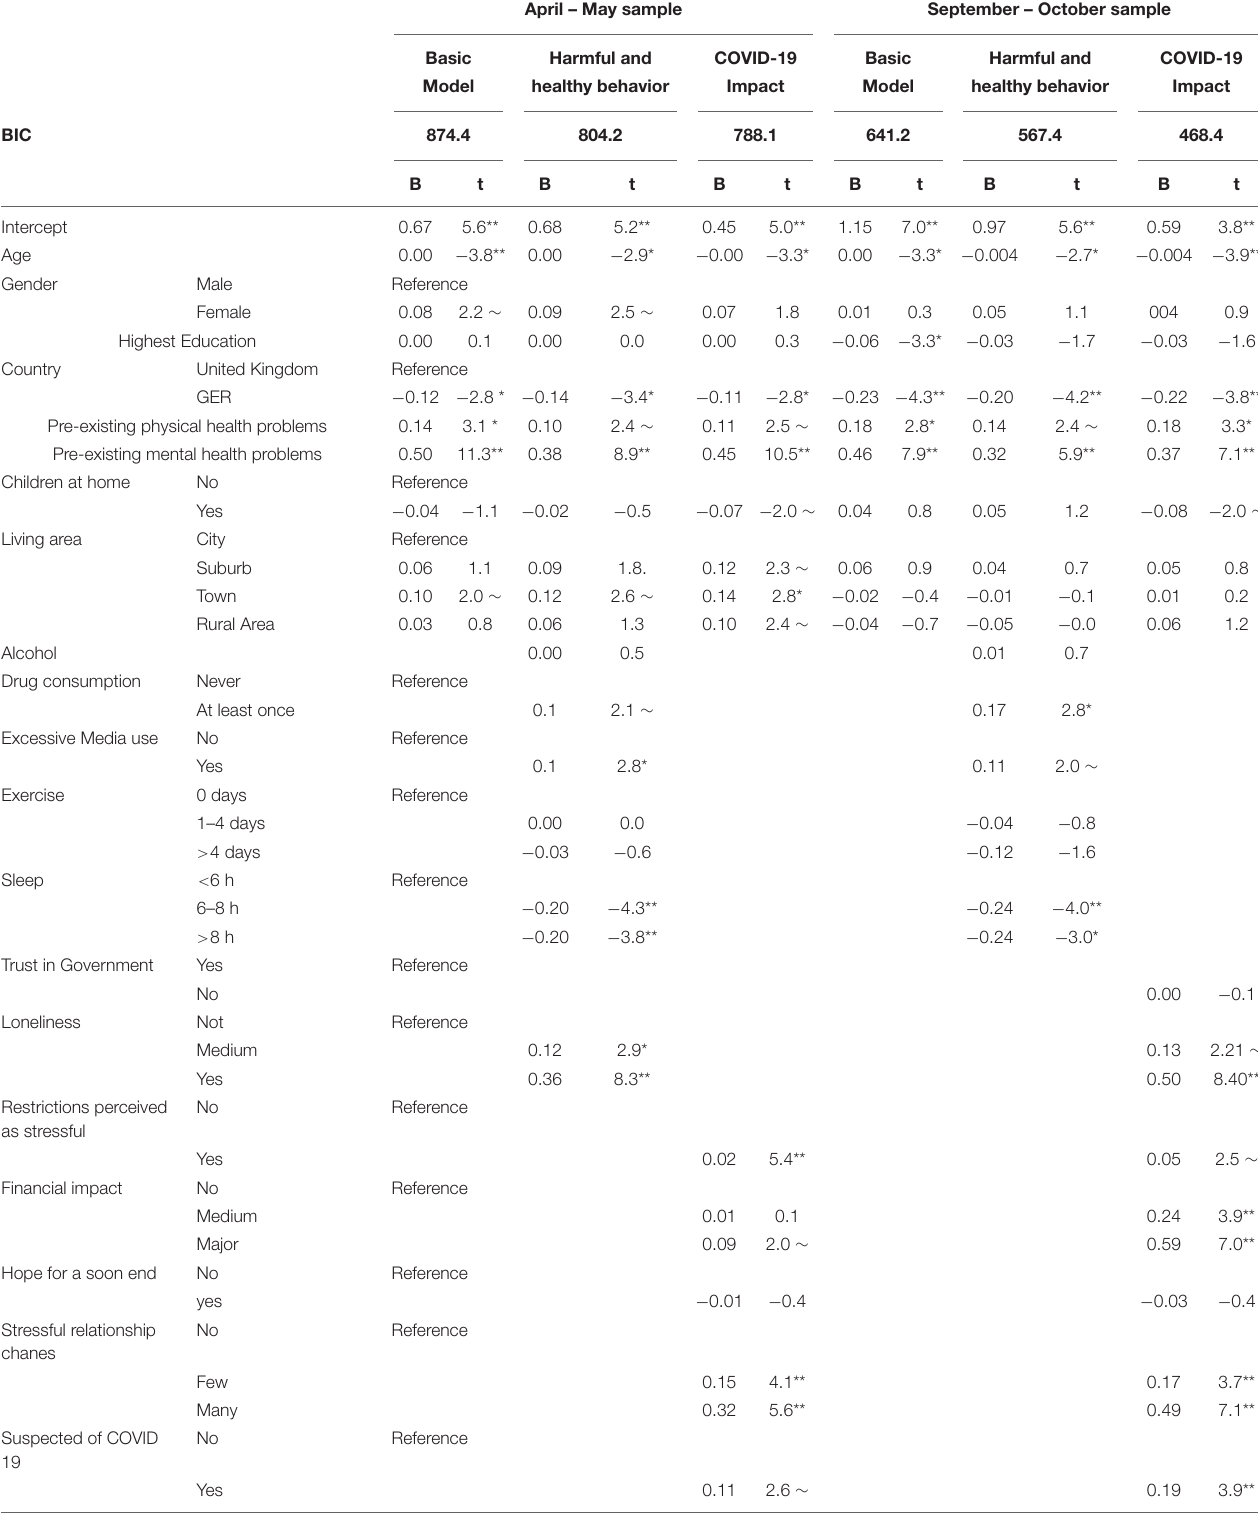
TABLE 3 | Overview over all three conducted models (Basic Model, Harmful and Healthy Behavior, COVID-19 Impact) for both samples for GSI